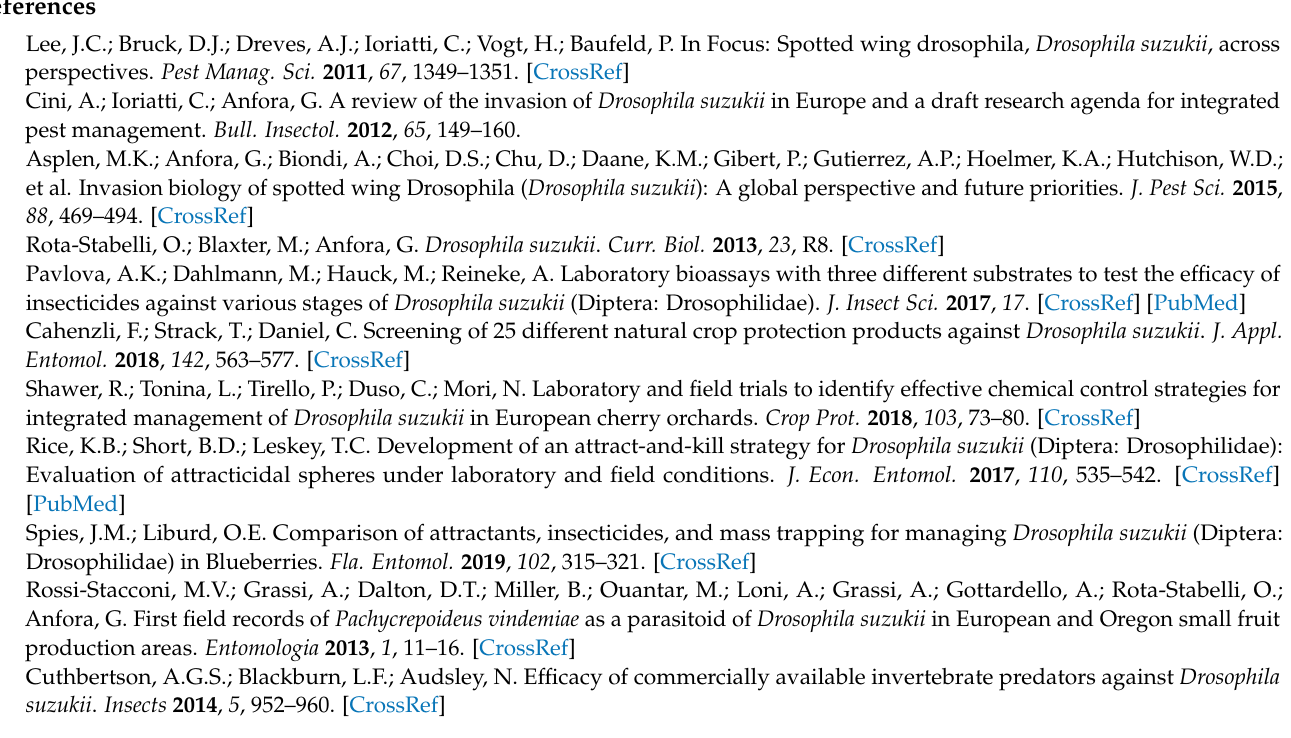
Table S1: Field assessment of attractiveness of Droskidrink ® baits inoculated with lactic acid bacteria, Table S2: Assessment of O. oeni strains’ growth in Droskidrink ® bait, Table S3: